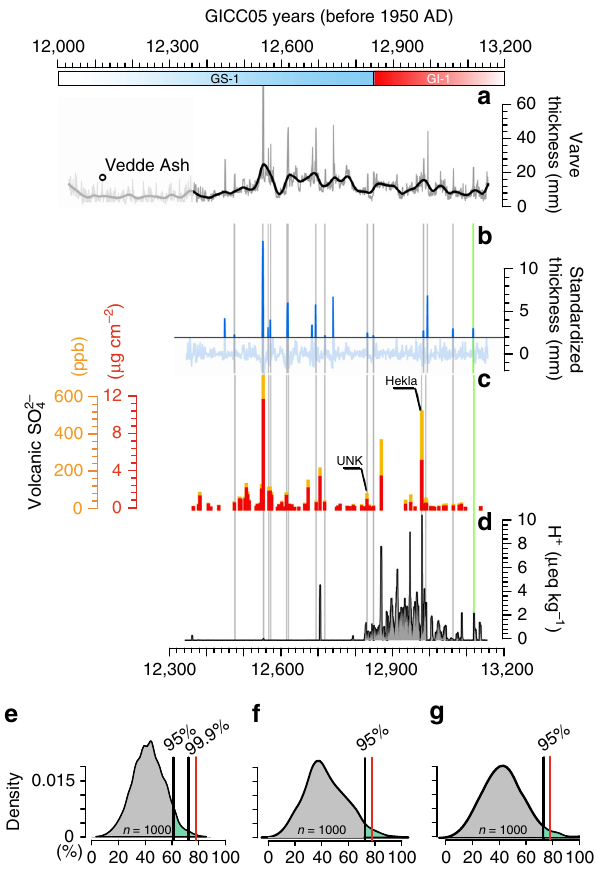
Fig. 2 Comparison between the glacial clay-varve chronology and Greenland ice-core volcanic records. a Uni fi ed varve thickness diagram synchronized to the GICC05 time scale 13 and presented with a 10-year running mean smoothing line (black). The ‘ b2k ’ convention of the GICC05 time scale is here converted into BP (1950 years AD). The transition from Greenland Interstadial 1 (GI-1) to Greenland Stadial 1 (GS-1) is also displayed. b Varve thickness standardized anomalies of the portion of the varve chronology composed by 56 (out of 57) overlapping varve diagrams (see text for details). c Volcanic SO 4 2 − signal recorded in GISP2 expressed as absolute values (orange) and as fl ux (red). d Hydrogen ion measurements from the NGRIP2 ice-core re fl ecting the acidity of the ice 20